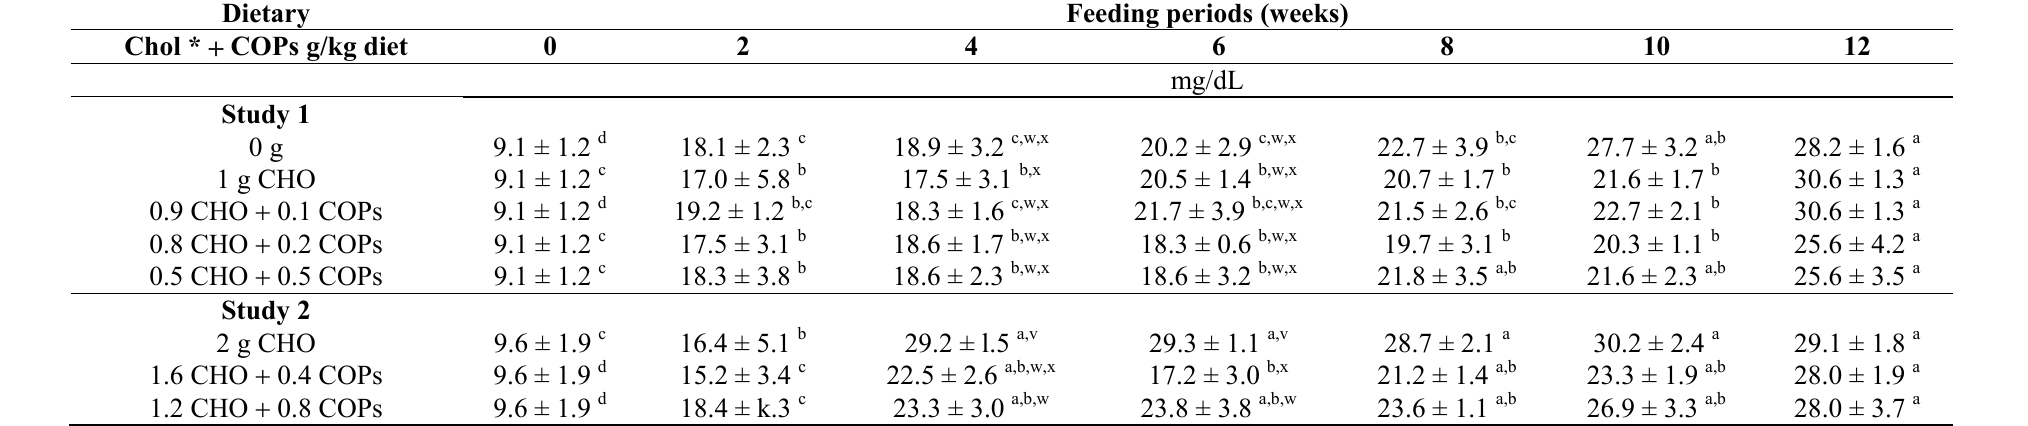
Table 5. Effect of dietary cholesterol and cholesterol oxides on HDL-cholesterol content in serum. Dietary Feeding periods